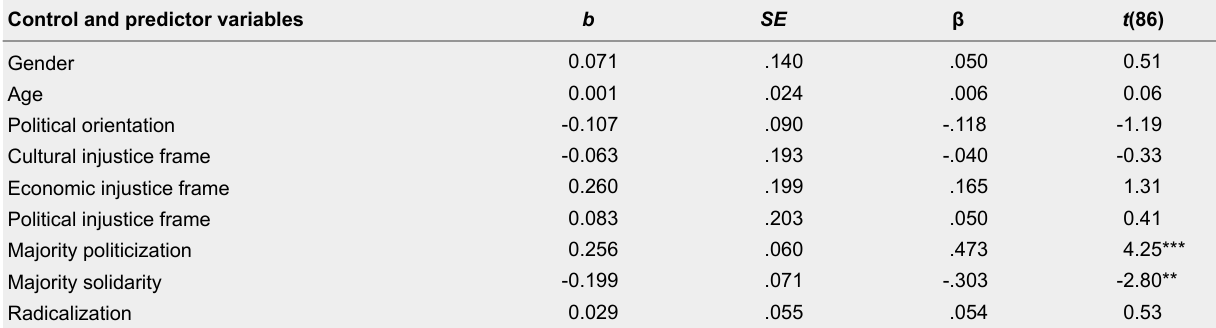
t (86)β SEb Control and predictor variables